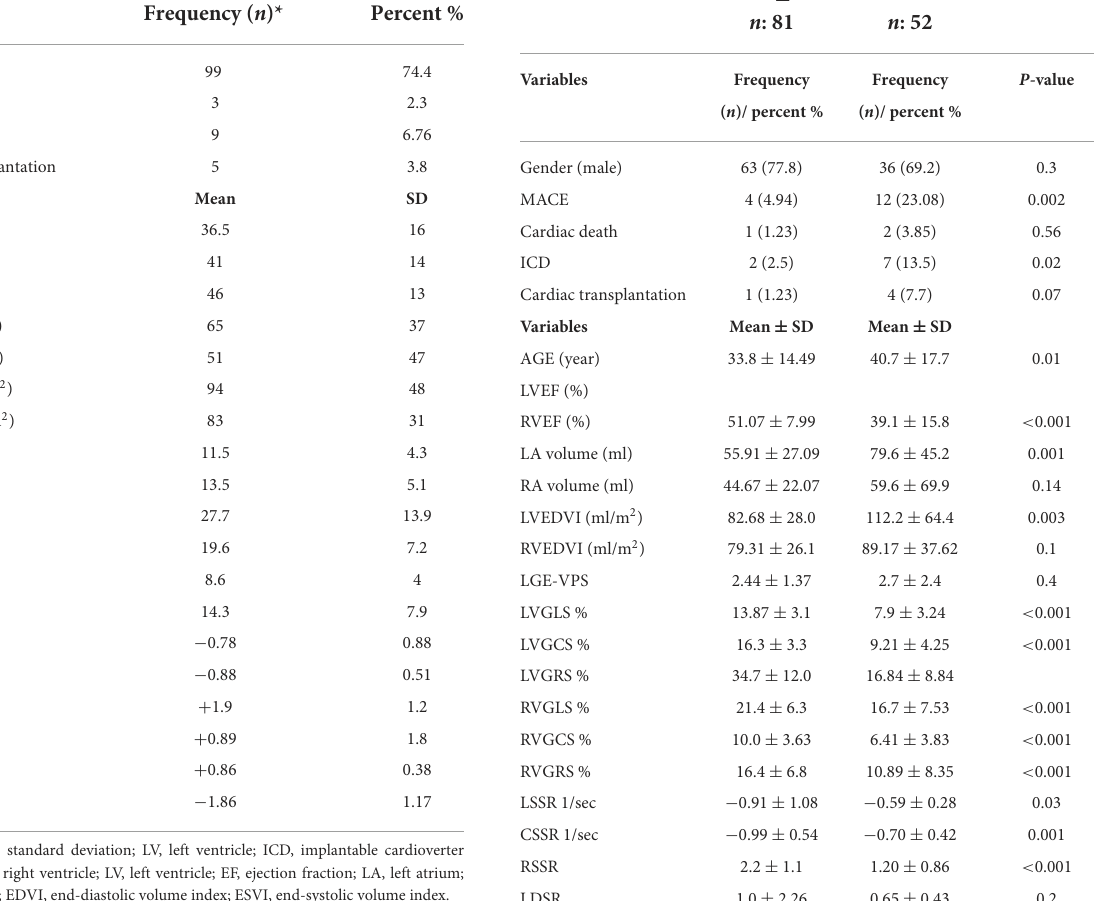
TABLE 2 Comparisons of CMR parameters between LVEF